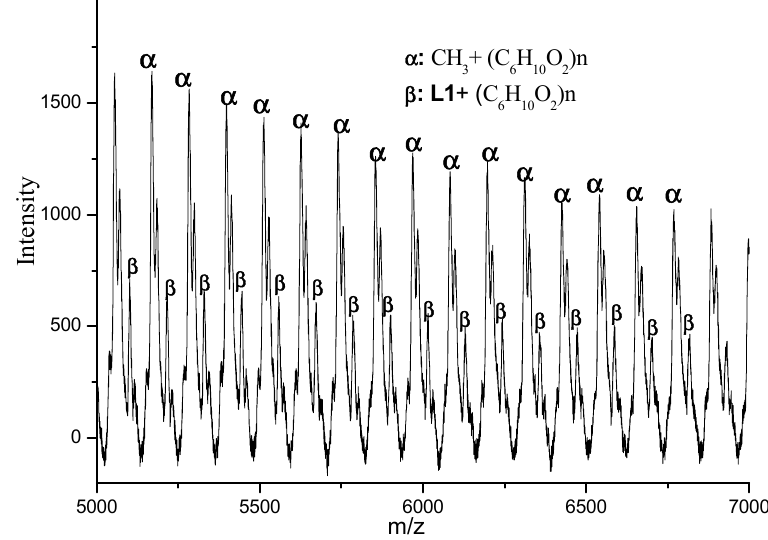
Figure 3. The MALDI-TOF mass spectrum of the PCL obtained using C1 (run 13, Table 3).